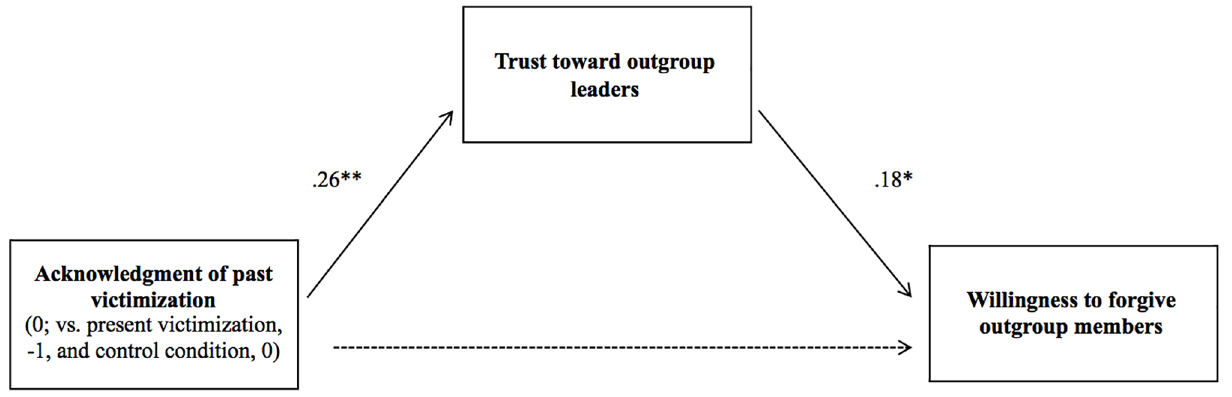
Figure 1. Results of mediation analyses testing the indirect effects of acknowledgment of past victimization (vs. acknowledgment of present victimization) on willingness to forgive via trust toward outgroup leaders. Contrast